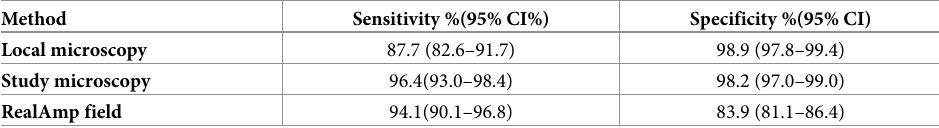
Table 3. Sensitivity and specificity of the laboratory assays among samples collected in Cruzeiro do Sul, Acre state (n =